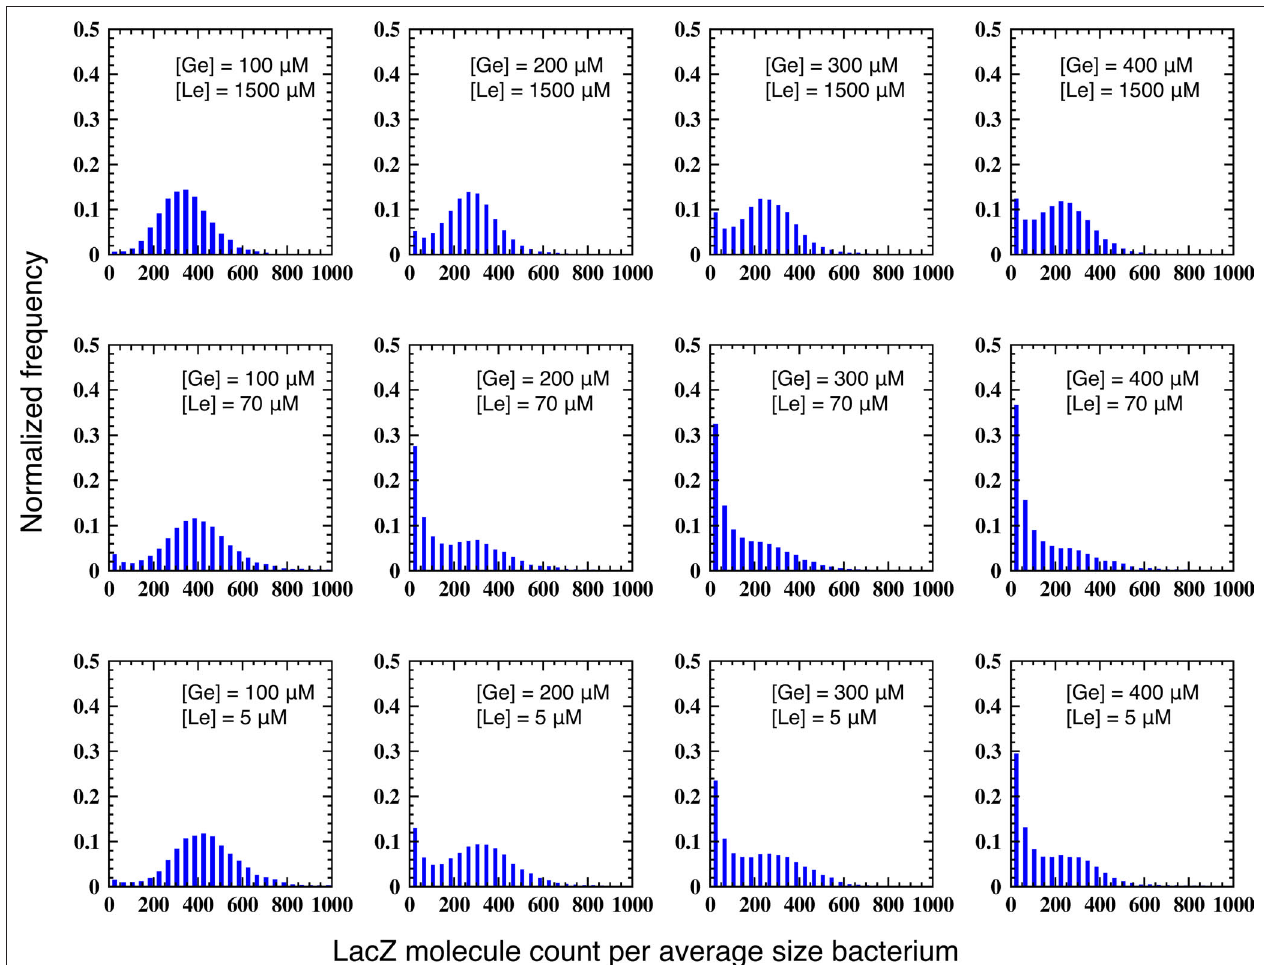
Figure 5 | Histograms of LacZ polypeptide molecule count per bacterium, calculated from stochastic simulations carried out with the set ([ G points shown in Figure 4B and [ T